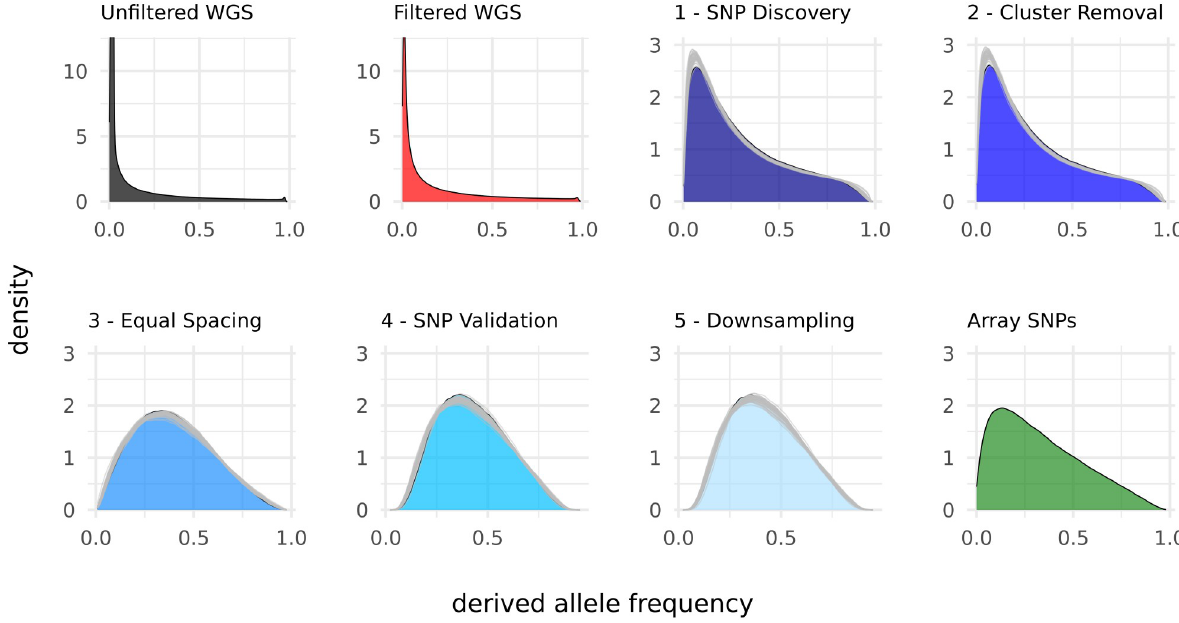
Fig 2. Derived allele frequency spectra for the different SNP sets. For the remodeled sets, areas show the modelling according to the original array [21] while grey lines represent the 50 random population groupings.